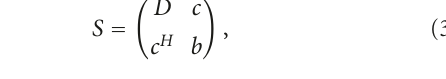
This process performs two steps alternatively (cf. Figure